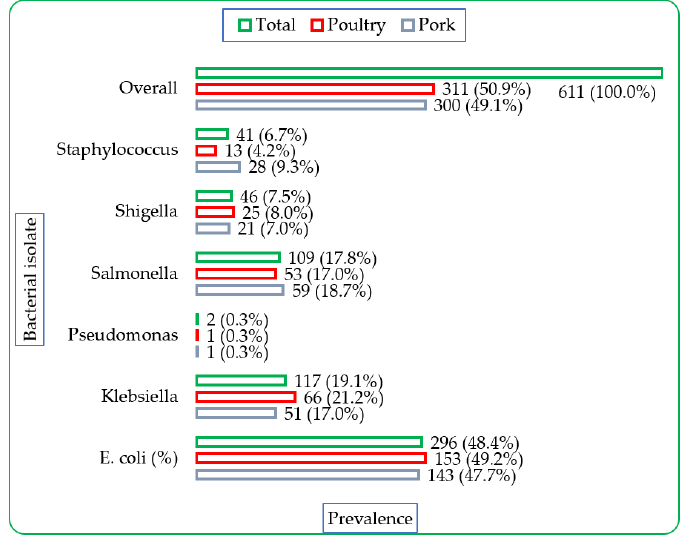
Figure 1. Figure showing the prevalence of bacterial contaminants that were isolated. The overall proportions for poultry and pork isolates were determined by analyzing the 611 total isolates recovered, which included 311 poultry and 300 pork.